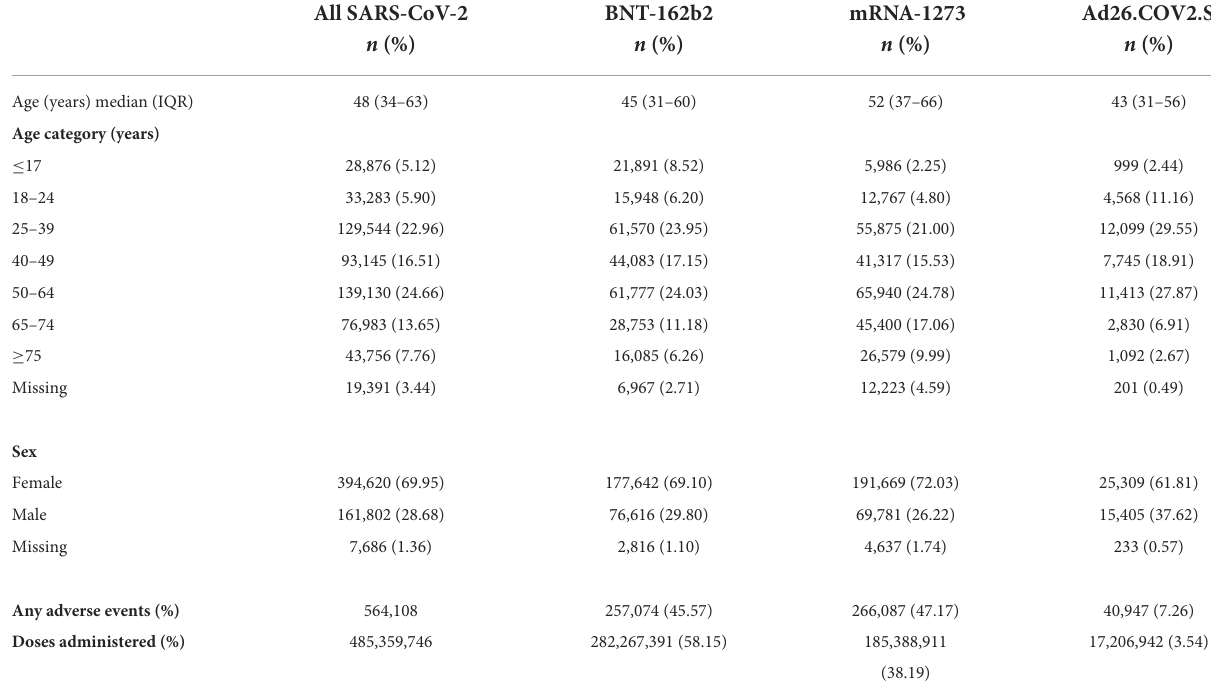
cumulative total sAEFI during study period are shown in Supplementary Figure 2.